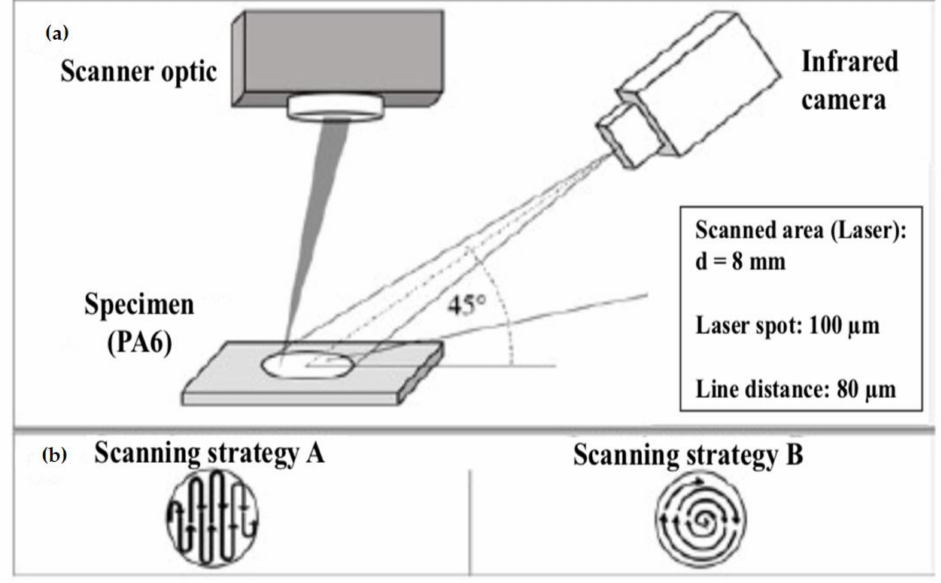
Figure 12. ( a ) Experimental set-up to analyse the temperature distribution; ( b ) Investigated scanning strategies, A (bidirec- tional) and B (spiral) [191]. Reproduced with permission from [191]. Copyright (2018), Procedia